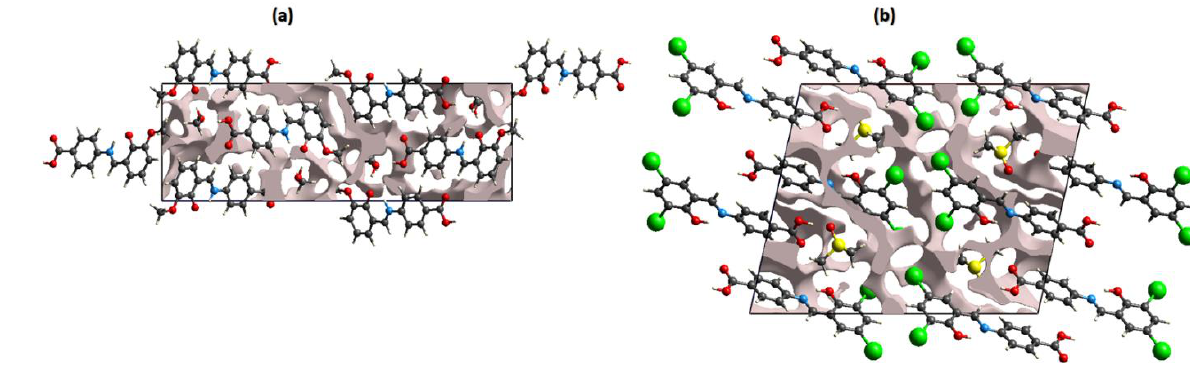
Figure 4. Graphical illustration of voids in ( a ) HMBA along a-axis, ( b ) DHBA along b-axis.